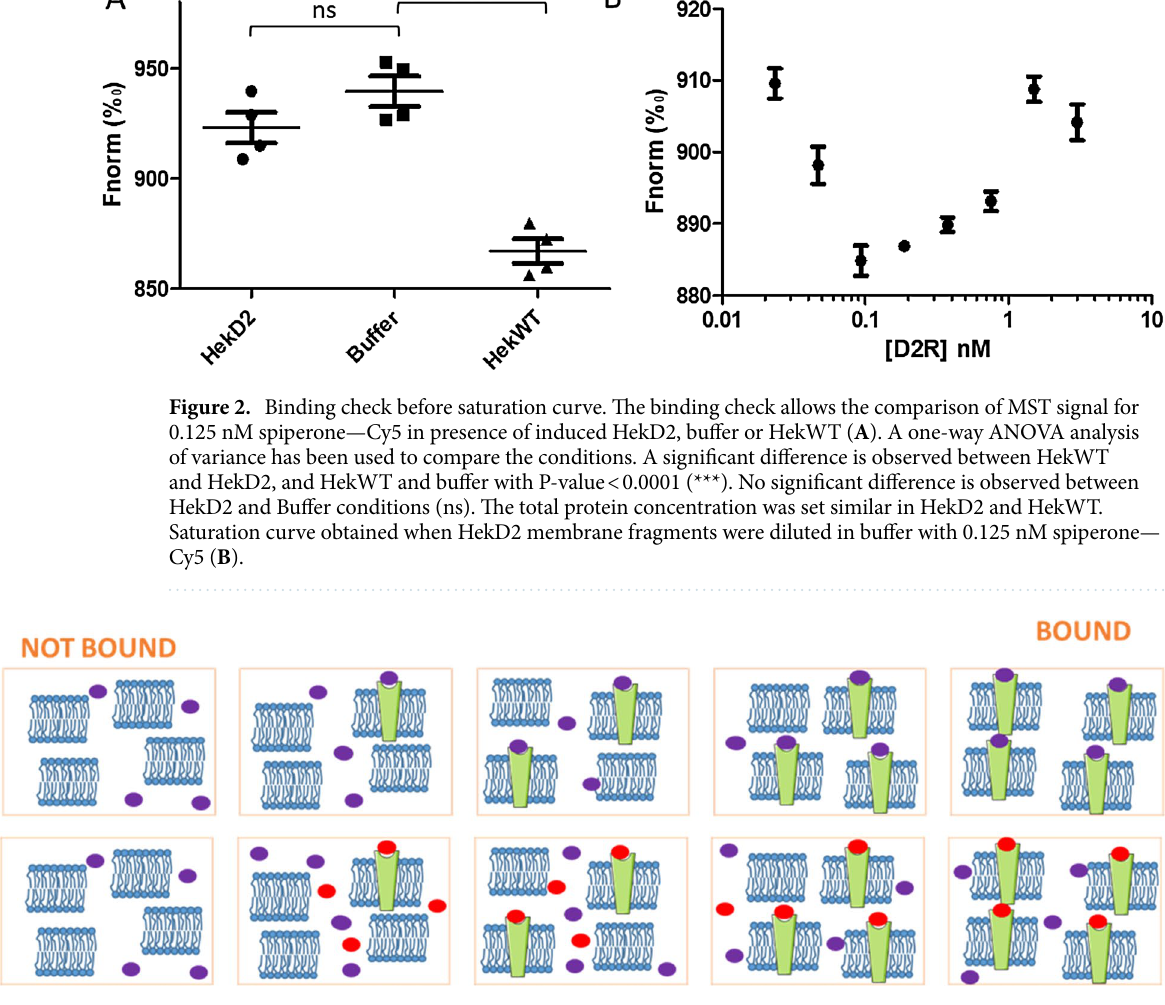
Figure 3. HekD2 membrane fragments (D2R in green) are diluted in HekWT membrane fragments ( A ). To characterize the presence or not of non-specific binding, a high concentration of non-labelled D2R antagonist, haloperidol (red), is added in each dilution point to compete with labelled ligand (violet) ( B